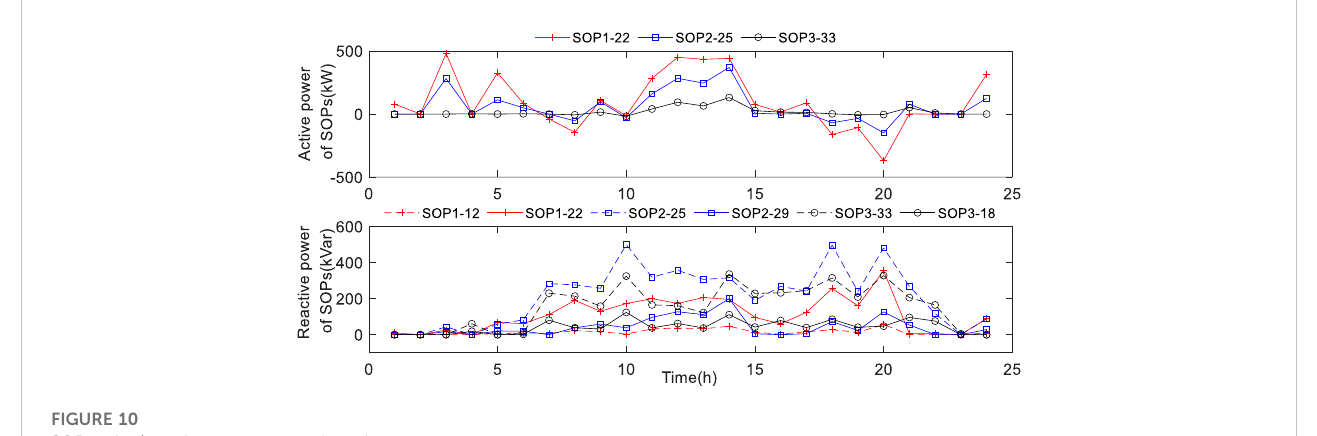
FIGURE 10 SOP active/reactive power control result.